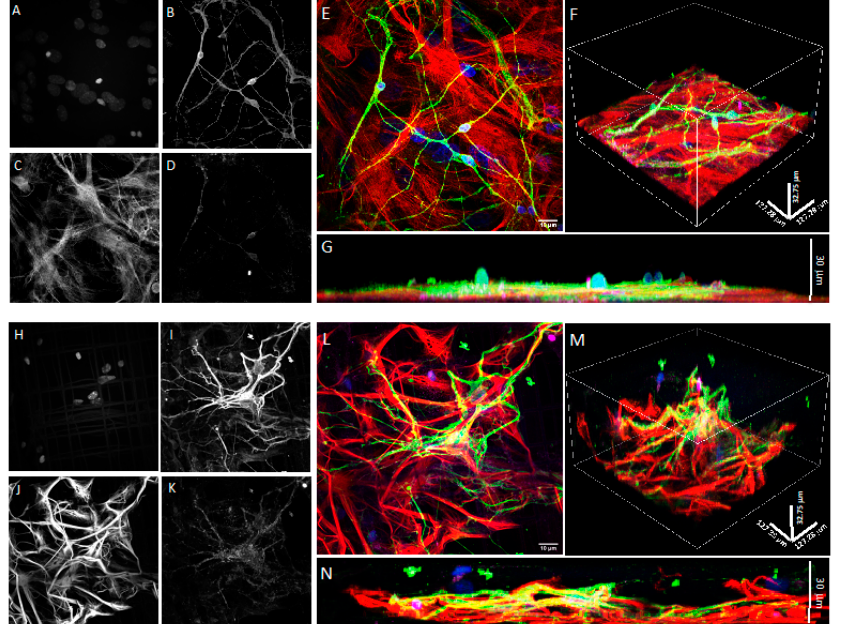
Figure 8. Confocal microscopy of DIV21 hippocampal co-cultures of astrocytes and neurons in 2D and in the 3D synthetic microscaffold Nichoid. ( A – D ) Grayscale images from horizontal sections of 2D hippocampal astrocyte and neuron co-cultures marked with Hoechst ( A ), MAP2 ( B ), GFAP ( C ), and PSD95 ( D ). ( E ) Merged fluorescence image of 2D co-culture with Hoechst in blue, MAP2 in green, GFAP in red, and PSD95 in violet. ( F , G ) Lateral views of the 2D co-cultures displayed in ( E ). ( H – K ) Grayscale images of horizontal sections of 3D hippocampal co-cultures of astrocytes and neurons marked with Hoechst ( H ), MAP2 ( I ), GFAP ( J ), and PSD95 ( K ). ( L ) Merged fluorescence image of the 3D hippocampal co-cultures with Hoechst in blue, MAP2 in green, GFAP in red, and PSD95 in violet. ( M , N ) Lateral view of 3D co-cultures displayed in L. Images were taken with a 100× (oil immersion) objective .